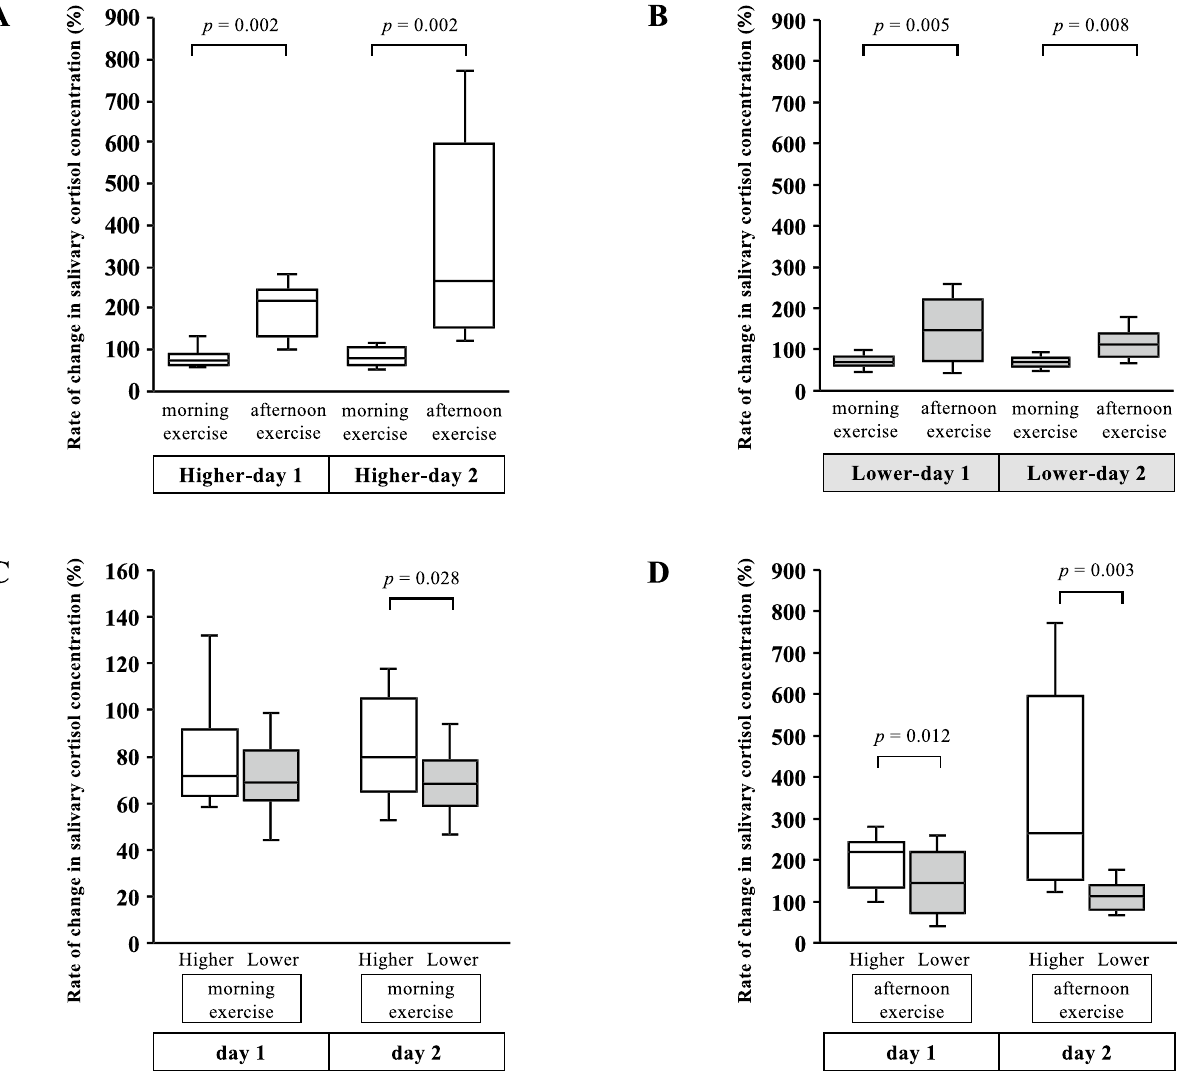
Figure 3. Comparison of the rate of change in the salivary cortisol concentration resulting from exercise between the morning and afternoon time points on days 1 and 2 at the higher-altitude camp ( A ), lower-altitude camp ( B ), between the morning time points on days 1 and 2 at the higher- and lower-altitude camps ( C ), and between the afternoon time points on days 1 and 2 at the higher- and lower-altitude camps ( D ). The white box plots denote the rates of change in the cortisol concentration at the higher-altitude camp, whereas the gray box plots represent those at the lower-altitude camp. The significant differences between two time points of exercise for runners were analyzed using the Wilcoxon signed-rank test. Higher-day 1, day 1 at the higher-altitude camp; Higher-day 2, day 2 at the higher -altitude camp; Lower-day 1, day 1 at the lower-altitude camp; Lower-day 2, day 2 at the lower-altitude